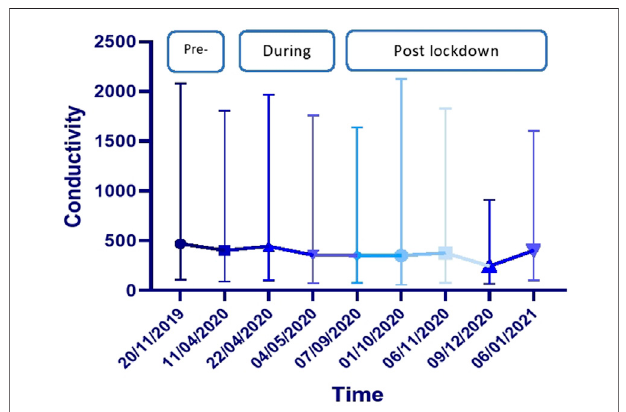
FIGURE 5 | Time series plot for the EC values during the pandemic in Yamuna